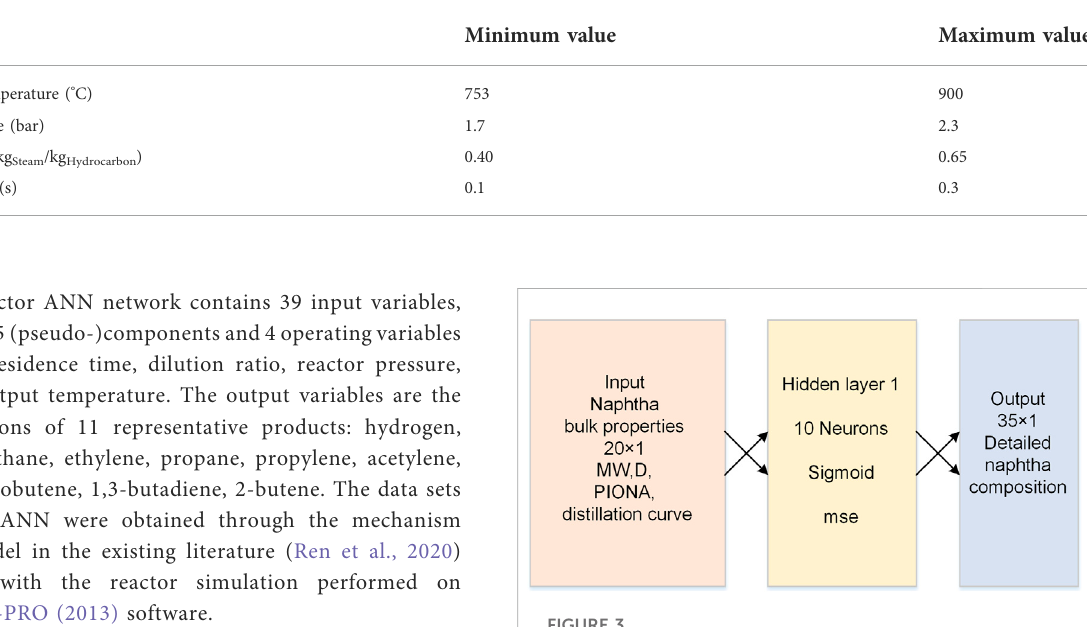
TABLE 2 Ranges for process operation-related input variables of reactor ANN.